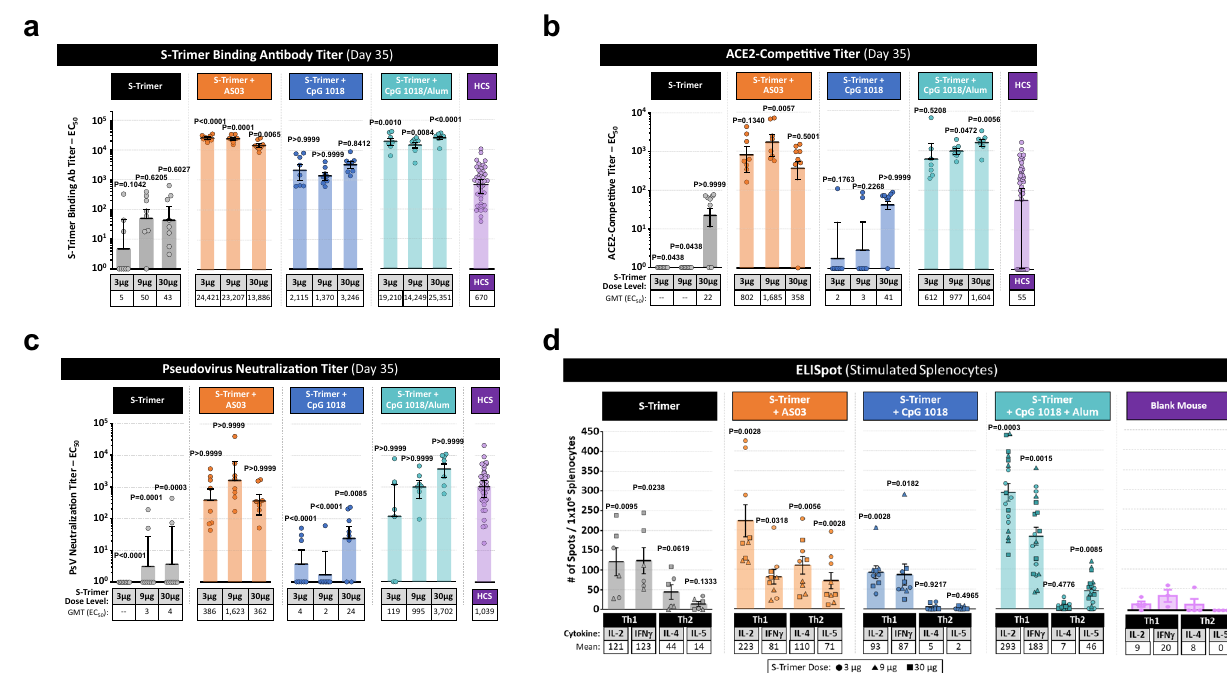
Fig. 3 Immunogenicity of S-Trimer in mice. BALB/c mice ( n = 7 – 8/group) were immunized with various doses of S-Trimer that was non-adjuvanted or adjuvanted with 25 µ L AS03, 10 µ g CpG 1018, or 10 µ g CpG 1018 plus 50 µ g alum twice on Day 0 and Day 21. The humoral immune responses on Day 35 were analyzed and compared with a human convalescent sera (HCS) panel ( n = 41), based on a S-Trimer binding antibody ELISA titers, n = 7 – 8, b ACE2- competitive ELISA titers, n = 7 – 8, and c SARS-CoV-2 pseudovirus neutralization titers, n = 7 – 8. After necropsy, splenocytes were harvested from mice and stimulated with S-Trimer antigen, followed by d detection of Th1 (IL-2, IFN γ ) and Th2 (IL-4, IL-5) cytokines by ELISpot. ELISpot data shown represents pooled data across S-Trimer doses (S-Trimer group, n = 6; S-Trimer + AS03 group, n = 9; S-Trimer + CpG group, n = 9; S-Trimer + alum + CpG group, n = 18; and Blank mouse group, n = 3 – 4). Points represent individual animals or humans; horizontal lines indicate geometric mean titers (GMT) for antibody assays and mean values for ELISpot assay for each group ±SEM. For statistical analysis of antibody titers, all comparisons were made against HCS sera using Kruskal – Wallis ANOVA with Dunn ’ s multiple comparisons tests. In the ELISpot assays, for all cytokines, the comparisons were compared to blank mouse control with Two-tailed Mann – Whitney tests. P values < 0.05 were considered signi fi